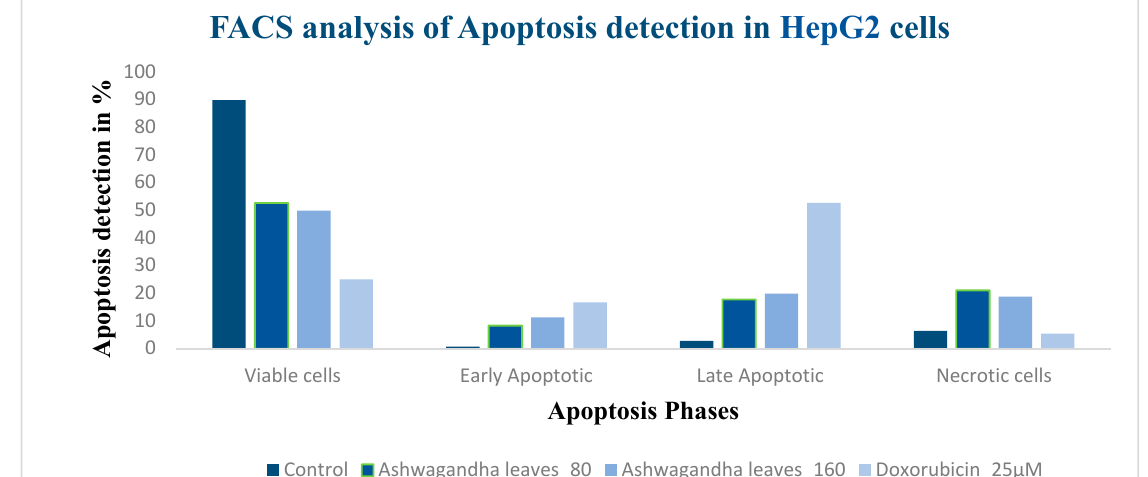
Figure 10. Flow cytometry analysis of apoptosis detection of HepG2 cells. 3.9. Gene Regulation of BAX and Bcl 2 in HepG2 Cell Line Treated with Sample Ashwagandha BAX and BCL II gene expression is quantified in the HepG2 cell line by semi-quanti- tative PCR. (Figures 11 and 12)The internal control GAPDH gene was used to normalize the BAX and BCL II gene expression levels. The W. somnifera treatment at different con- centrations on the HepG2 cell line has shown significant regulation of the BAX gene. At 80 μ g/mL and 160 μ g/mL concentrations, the BAX gene expression has shown upregula- tion to 1.05 and 1.21, respectively, in the HepG2 cell line (Figures 13 and 14). The Ashwagandha treatment at different concentrations on the HepG2 cell line has shown significant downregulation of the BCL II gene. Concentrations of 80 μ g/mL and 160 μ g/mL showed downregulation of BCl2 gene expression to 0.71 and 0.65 in the HepG2 cell line, respectively. The positive control doxorubicin treatment at 25 μ M on the HepG2 cell line showed significant upregulation in BAX genes (to 1.33) and downregulation in BCL II genes (to 0.47) in the HepG2 cell line (Tables 5 and 6) and (Figures 15 and 16). Lane Doxo 25 μ M Figure 11. Sample loading order.